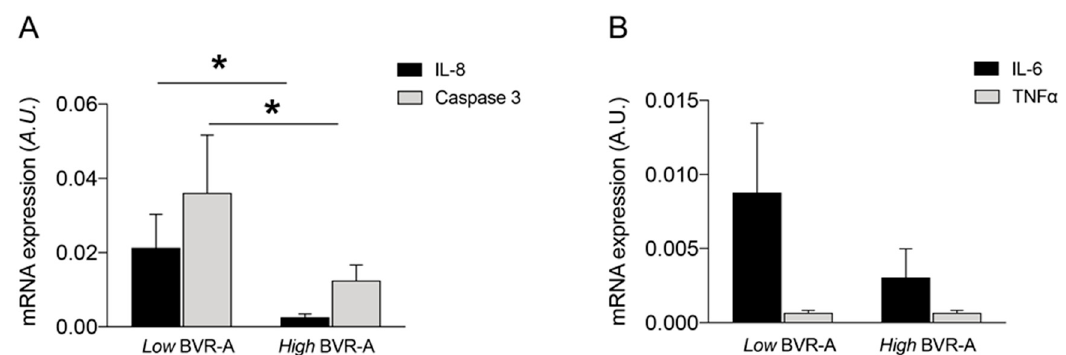
Figure 2. IL ‐ 8, Caspase 3 ( A ), IL ‐ 6 and TNF ‐α ( B ) mRNA expression levels in VAT relatively to BVR ‐ A mRNA expression levels. Subjects were dived into two groups based on BVR ‐ A mRNA expression levels below or above the median value (low and high BVR ‐ A, respectively). Data are expressed as mean ± SEM, * p < 0.05 (Mann–Whitney). A.U., arbitrary units.